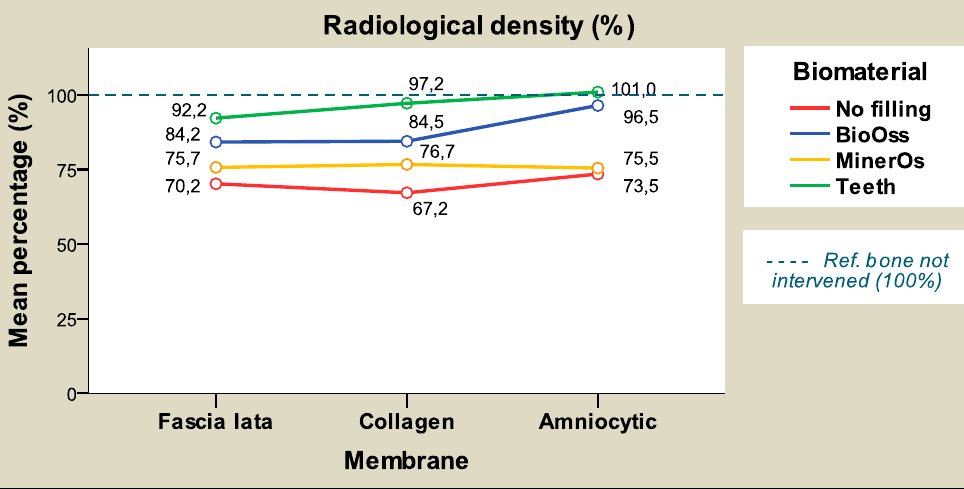
Figure 10 . The radiological density percentages (average) according to the membrane and filling material. 3.1. Histological Section Each tissue specimen was fixed in a formalin solution (neutral buffered, Sigma-Aldrich Co. LLC., St. Louis, MO, USA) for 2 weeks and then dehydrated while increasing the ethanol concentration of the tissue specimen. All the samples were dehydrated in a graded ethanol series (70, 90, 95% and absolute ethanol) after which the specimens were in fi ltrated with Technovit 7200 VLC, light curing resin (Heraeus Kulzer, Hanau, Germany) for 30 days while the percentage of resin was increased. Then, all the samples were embedded and light polymerized with an EXAKT 520 polymerizator system (EXAKT Technologies, Oklahoma City, OK, USA) and the resin was solidified for 1 day. Coronal sections were cut using the EXAKT 310 CP cutting unit (EXAKT Technologies, Oklahoma City, OK, USA). The sections obtained were approximately 250 µm in thickness and were